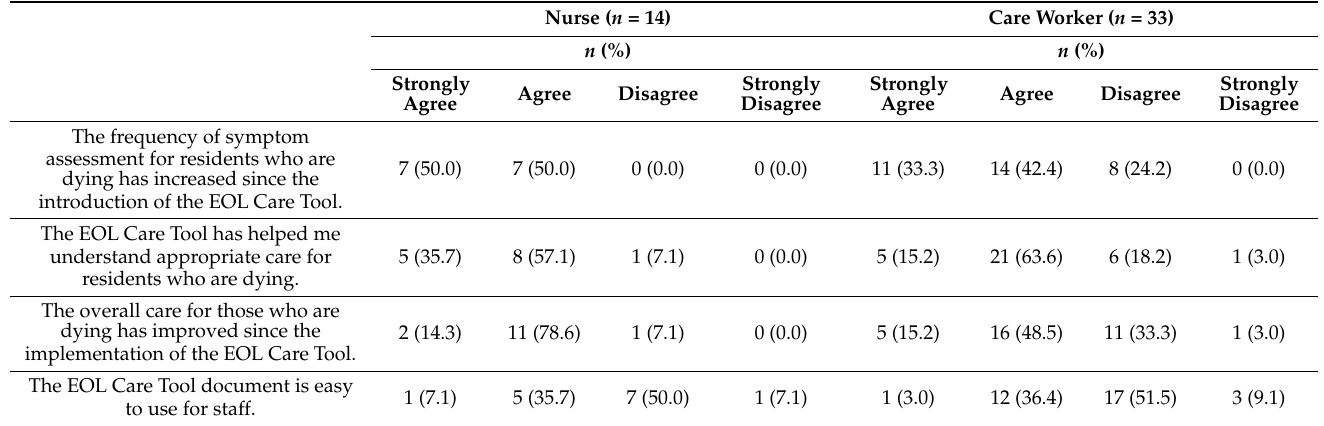
Table 4. Acceptability of the EOL Care Tool for nurses and care workers ( n =